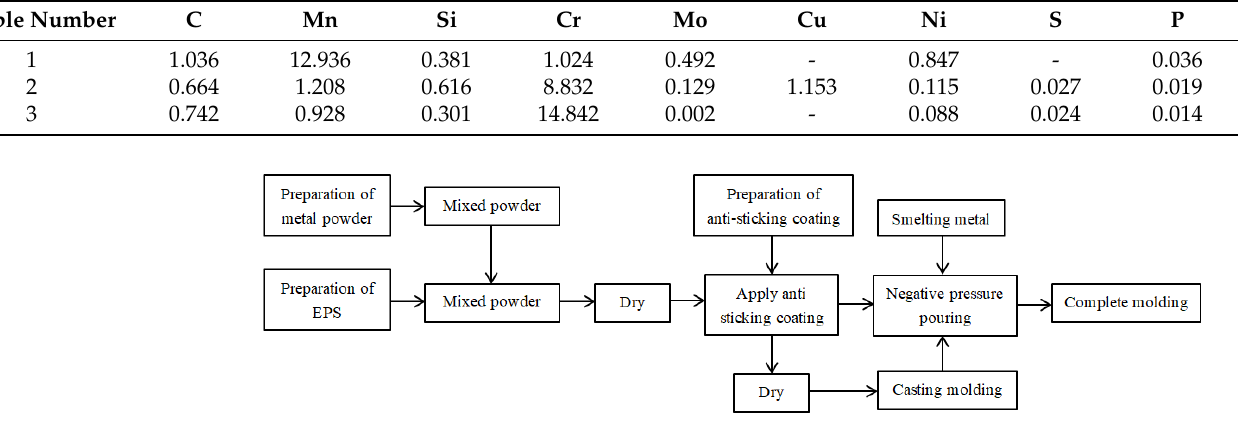
Figure 1. Process flow chart of surface coating cemented carbide coating.